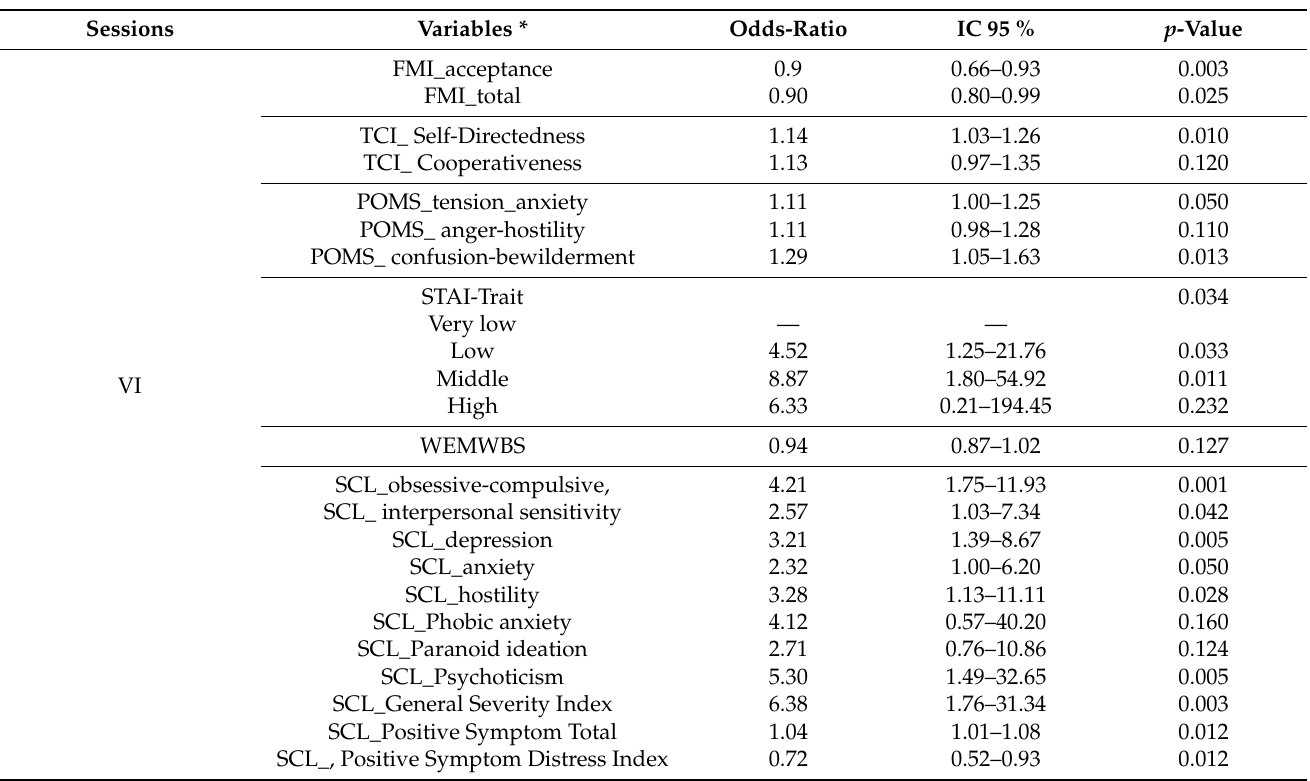
Table 5. The associations between potential predictors, measured at V1, VG or VP1, and postnatal depression, determined in univariate regression analyses. Only predictors that were significant at the 20% threshold in previous analyses are